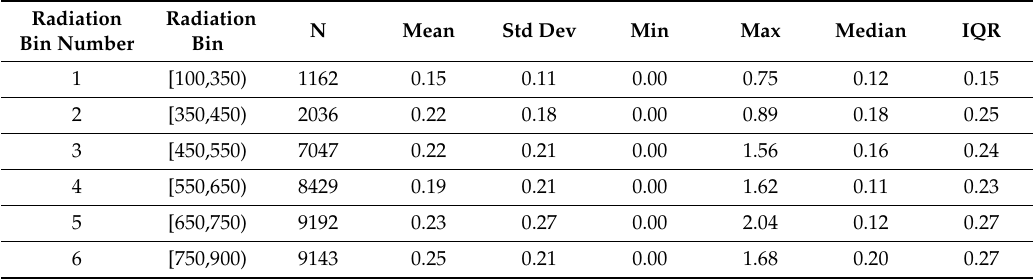
Table A3. Statistics of the Absolute Temperature Di ff erences in five solar radiation bins used to assess the precision of the iMET-XQ sensors as a function of solar radiation.